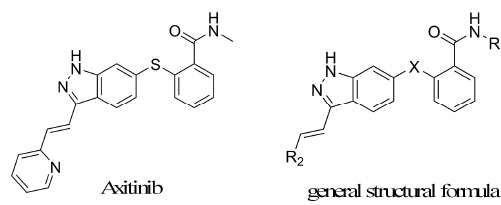
Figure 1. The structure of axitinib and derivatives general structural formula.